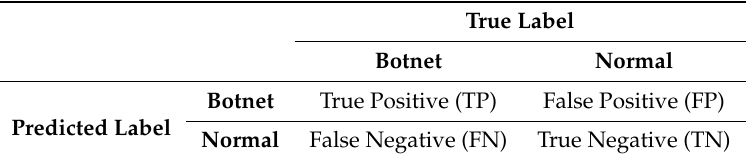
Table 2. The confusion matrix for botnet detection.